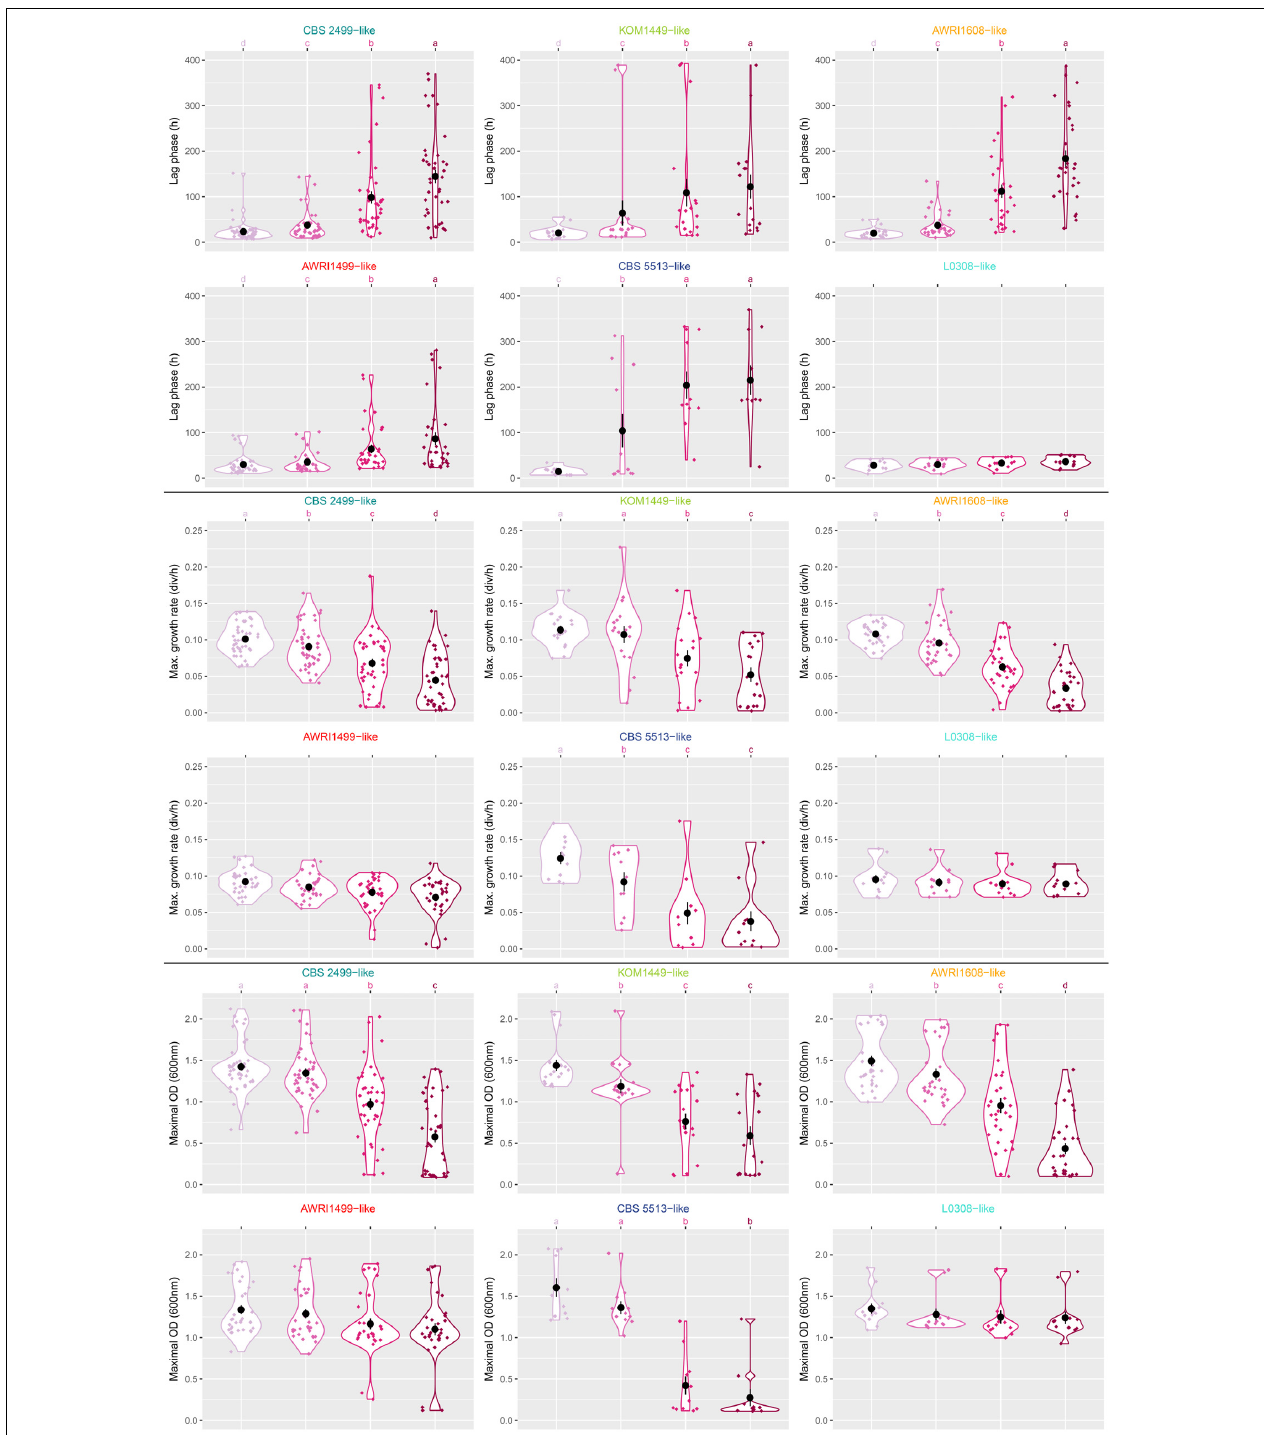
FIGURE 3 | Violin plots for three growth parameters and six genetic groups of B. bruxellensis . Three growth parameters were represented: lag phase (h), maximum growth rate (division per hour), and maximum OD (600 nm). For each genetic group, numeric values (corresponding to the different strains) are represented as diamonds, the corresponding probability densities are represented as plain traits, means, and standard errors are represented by black circles and segments, respectively. Increasing SO 2 concentrations are represented by the same coloring (pink shades, light pink corresponding to 0 mg/L and darker color representing increasing SO 2 concentrations) as in Figure 2 . The plots were obtained using ggplot2 package (R). Top letters represent significance groups as defined by Kruskal–Wallis test ( agricolae package, p -value < 0.05). Absence of top letters indicates non-significantly different sulfur conditions.